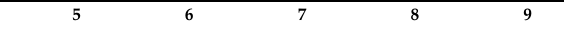
Table 4. The composition matrix after